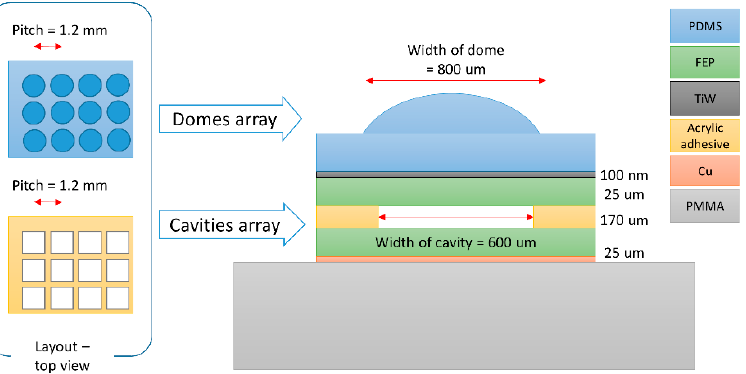
Figure 1. Schematic view of the flexible tactile sensor using FEP and PDMS with an array of bumps on top.